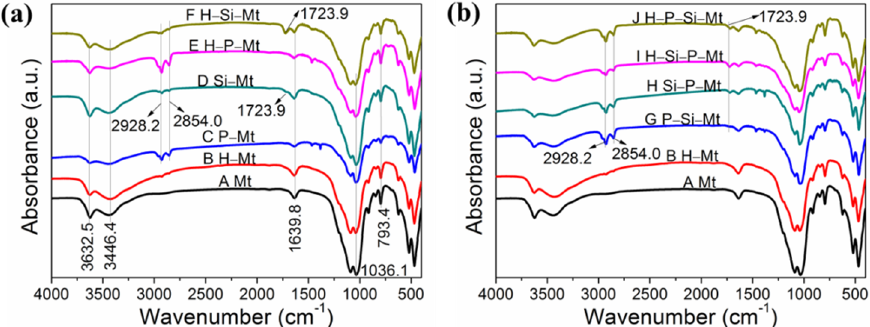
Figure 2. FTIR spectra obtained from the Mt and functionalized Mt samples. ( a ) FTIR spectra of